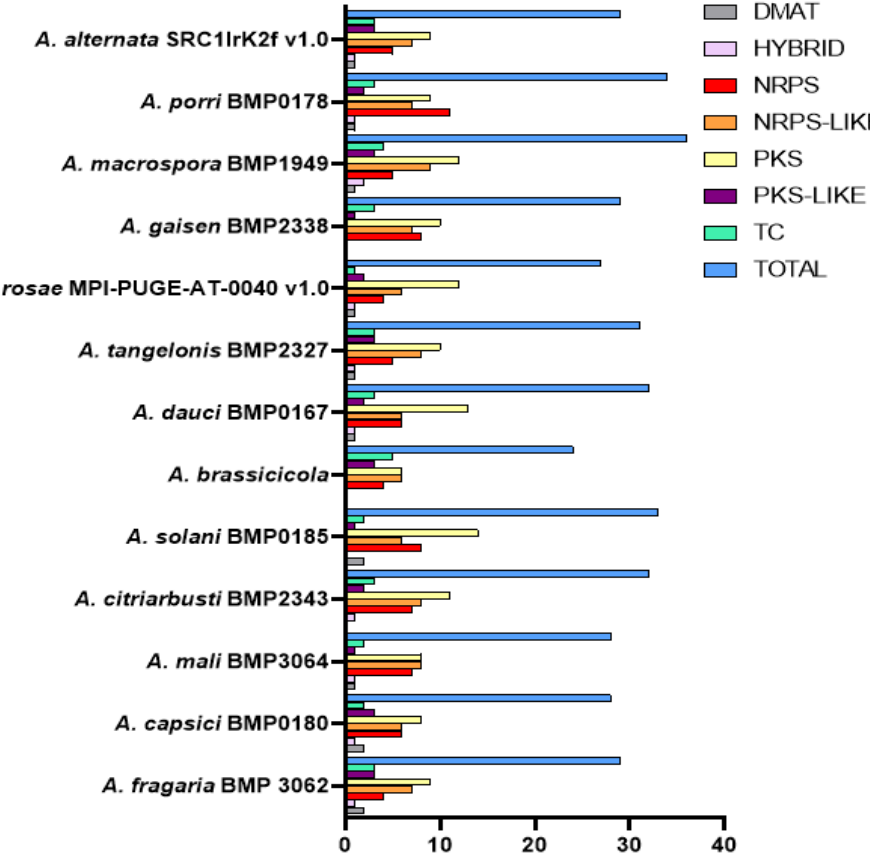
Figure 4. Secondary metabolites-related gene clusters in thirteen Alternaria species.